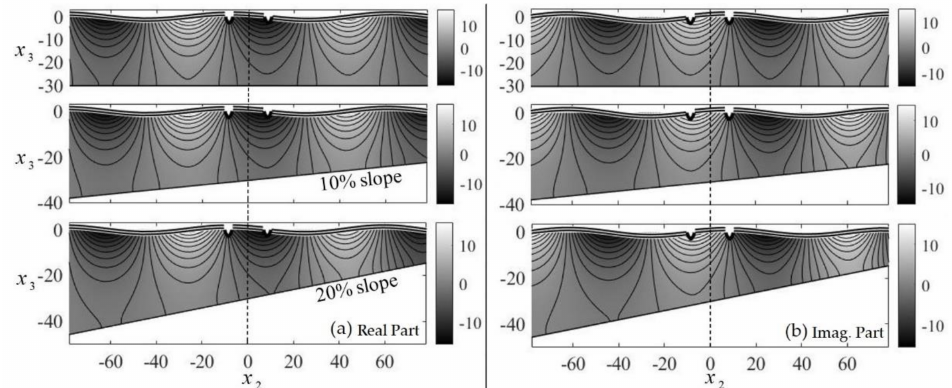
Figure 8. ( a ) Real and ( b ) Imaginary Part of the total complex wave potential and corresponding free surface elevation for a twin-hull floating structure of breadth B = 20 m and three considered cases of bottom slope 0, 10 and 20% in an environment with a mean depth of h = 30 m in the case of an incident wave of wavelength λ / h = 2.4 and amplitude A = 1.5